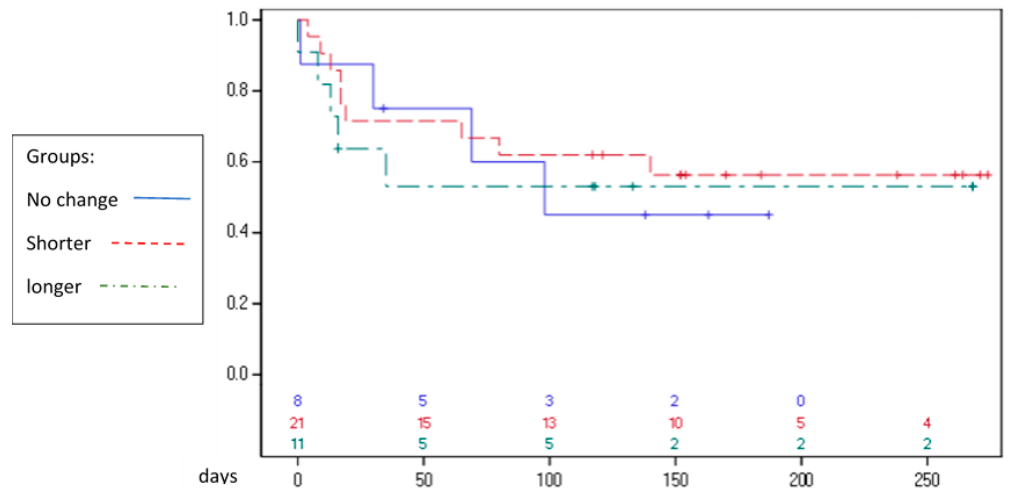
Figure 3. Kaplan-Meier curve. Follow-up of mortality from admission up to six months after study completion. Note that some patients were enrolled prior to others, hence the differential follow-up time.